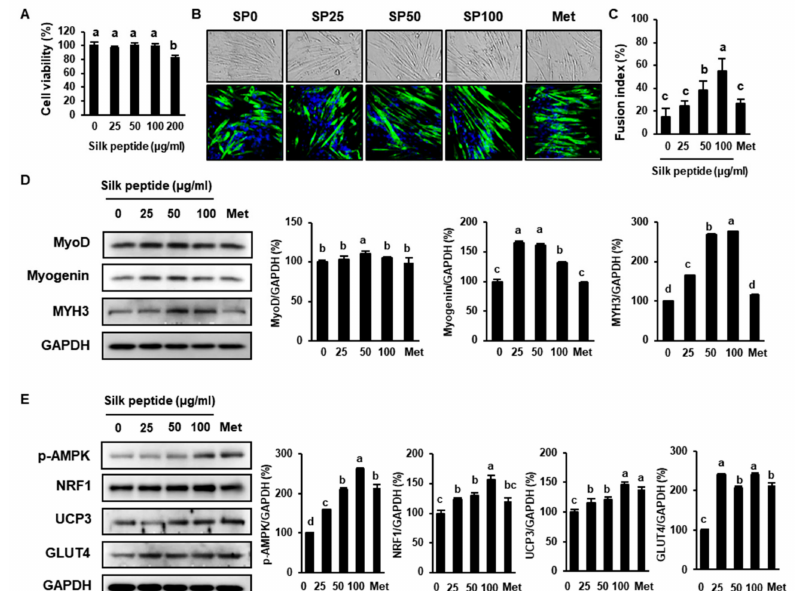
Figure 8. E ff ect of silk peptide on myoblast di ff erentiation and glucose uptake in C2C12 cells. ( A ) Viability of C2C12 cells treated with SP for 24 h. ( B ) Images of morphological change of C2C12 were obtained by an optical microscope (up, 200 × ). Immunofluorescence for the MYH3 expression of C2C12 in the presence or absence of SP (down, 400 × ). ( C ) Fusion index was calculated at the end of di ff erentiation by dividing the number of nuclei within multinucleated myofibers by the total number of nuclei. ( D ) Expression levels of proteins involved in muscle di ff erentiation (MyoD, Myogenin, and MYH3) were determined using western blotting. ( E ) Expression levels of mitochondrial proteins and proteins involved in glucose uptake (p-AMPK, PGC1 α , UCP3, and GLUT4) analyzed by western blotting. The data were analyzed using one-way ANOVA and Duncan’s test. Values with di ff erent letters are significantly di ff erent; p < 0.05 (a > b > c > d). Met; 2 mM